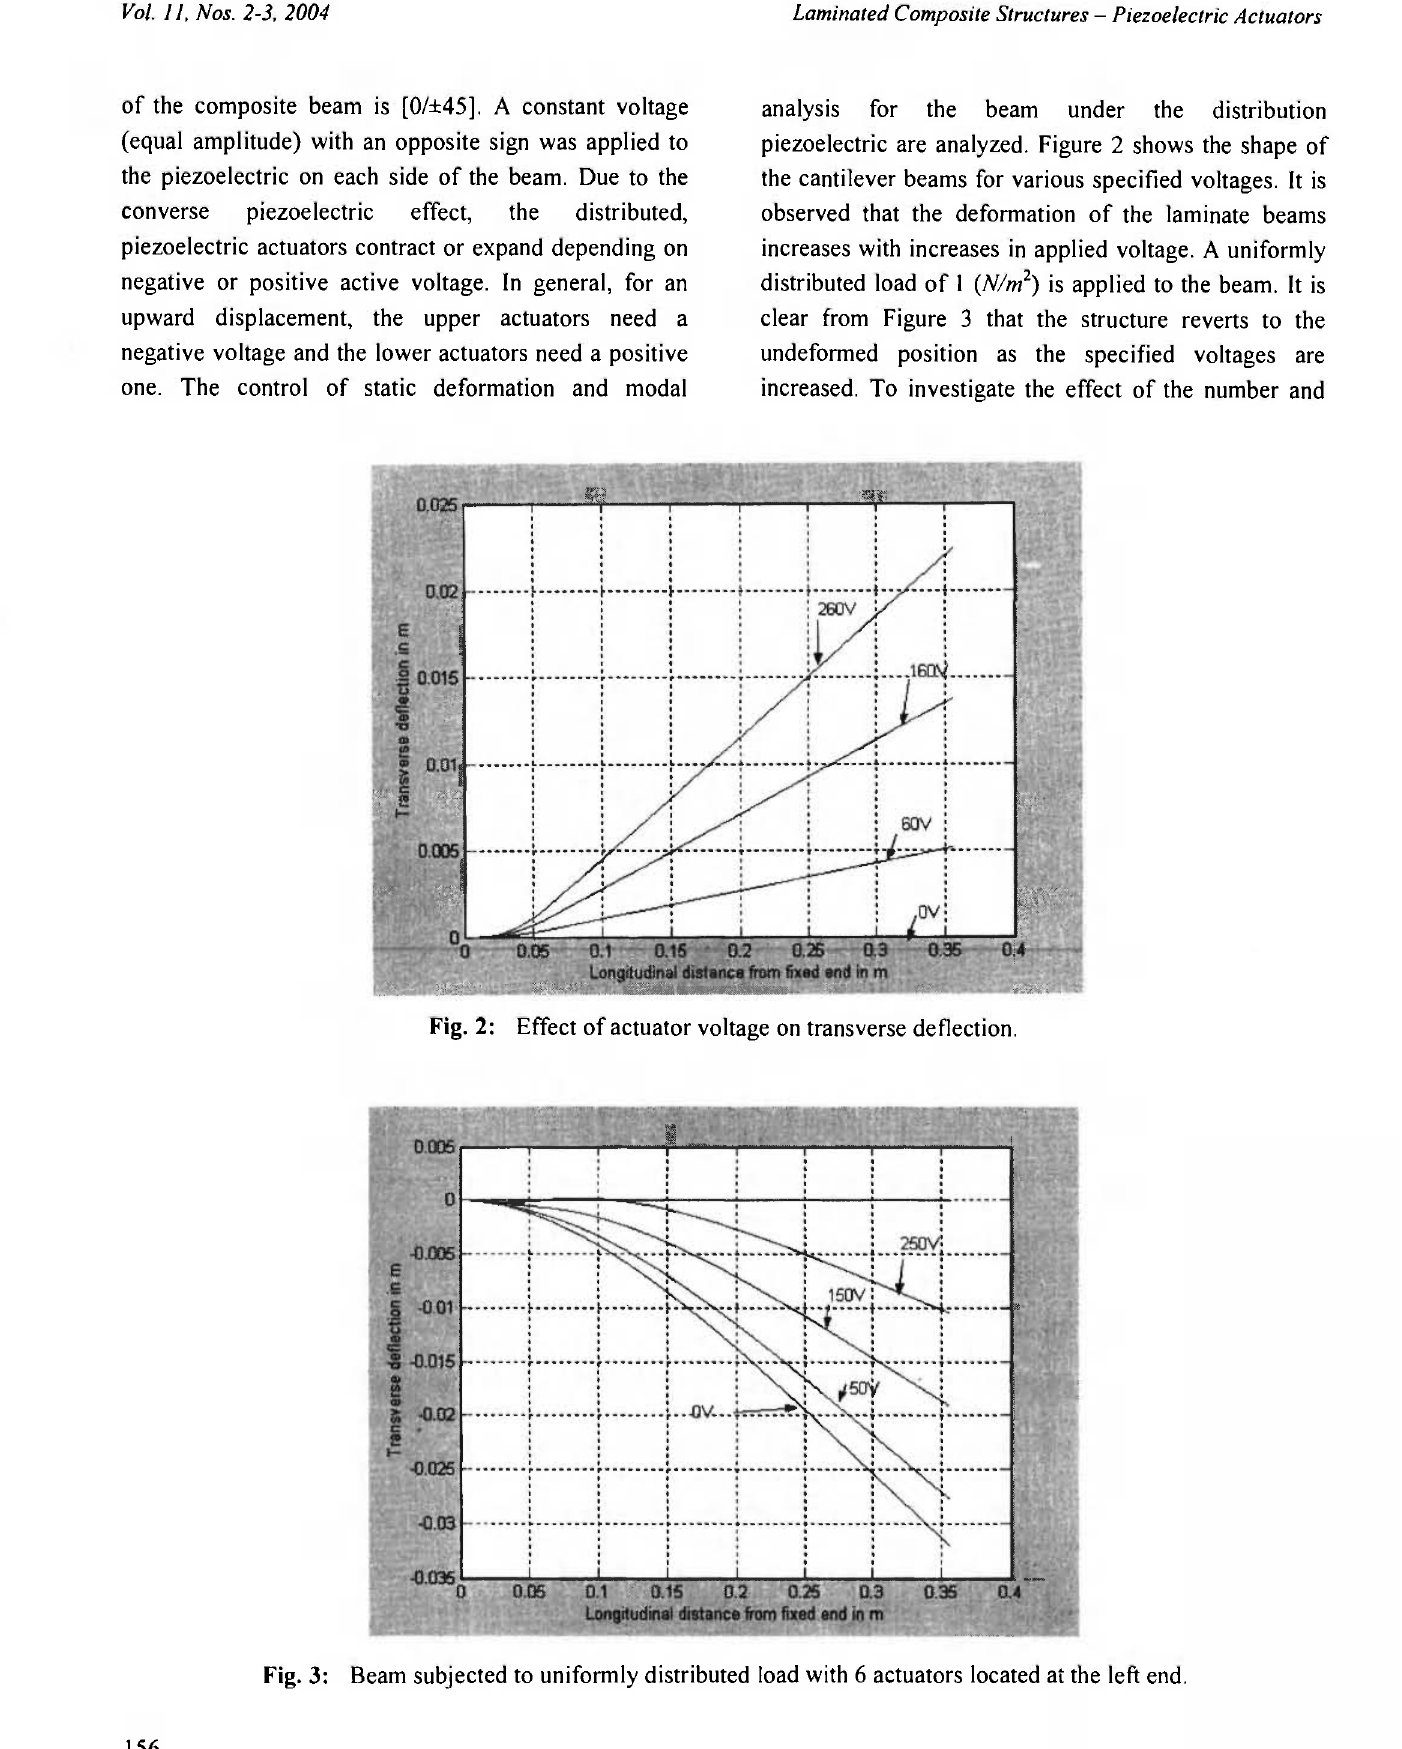
Fig. 3: Beam subjected to uniformly distributed load with 6 actuators located at the left